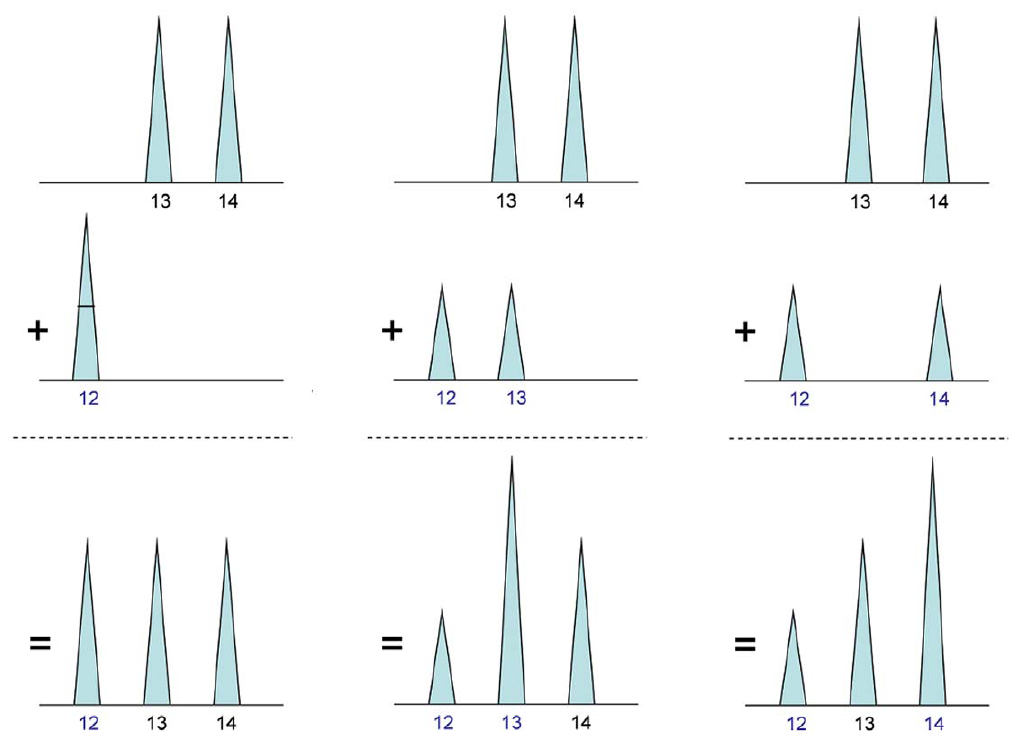
Figure 2. Different genotype combinations produce patterns that are compared with data to obtain a genotype probability. Linear combinations of known victim contributor ½ 13 14 (cid:1) with three different unknown contributor allele pair candidates are shown at STR locus Penta D. The victim contribution is known to be 70%, and the culprit’s is 30%. The allelic peak height pattern that best fits the observed data (Figure 1a) corresponds to the ½ 12 14 (cid:1) candidate (rightmost column). The other two candidates produce patterns that have a very poor fit to the quantitative data peaks. Therefore, based on a multivariate normal likelihood function, allele pair candidate ½ 12 14 (cid:1) would have the greatest probability of arising from the culprit genotype.